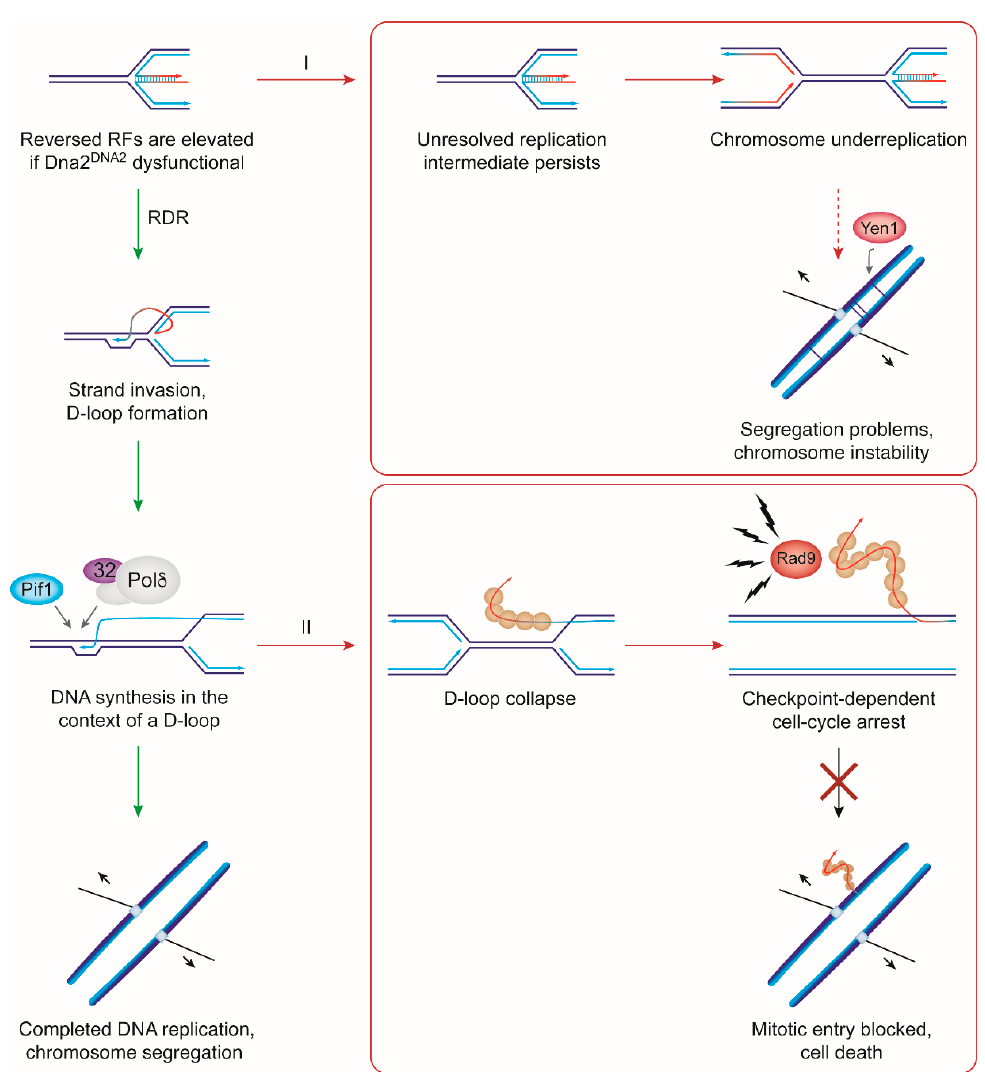
Figure 4. Model explaining why RF recovery by Dna2 is essential for cell viability. If Dna2 does not counteract RF reversal, chicken-foot structures accumulate, causing two problems: ( I ) Unresolved RFs persist, leading to impaired RF convergence and chromosome underreplication. If cells reach mitosis, anaphase bridges form between sister chromatids, resulting in mitotic catastrophe (partially mitigated by Yen1). ( II ) Persisting chicken-foot structures favor recombinational RF recovery by recombination-dependent replication (RDR). This promotes replication completion, but excessive RDR in the absence of Dna2, due to the intrinsic fragility of RDR intermediates, results in ssDNA exposure by way of D-loop collapse. ssDNA tracts may persist after RF convergence, which is potentially reflected in dsDNA with extended ssDNA tracts detected by EM upon Dna2 depletion [59]. RPA-bound ssDNA activates the Rad9-dependent DNA damage checkpoint, precluding cell-cycle progression and causing cell death. The model is supported by findings that Pif1/Rad9-driven toxicity in dna2 cells maps to Pif1 (cid:48) s role in RDR [84]. Likewise, Pol32 promotes D-loop DNA synthesis [92], and, similarly to Pif1, the absence of Pol32 suppresses the lethality of dna2 ∆ cells. Red DNA strands denote non-productive